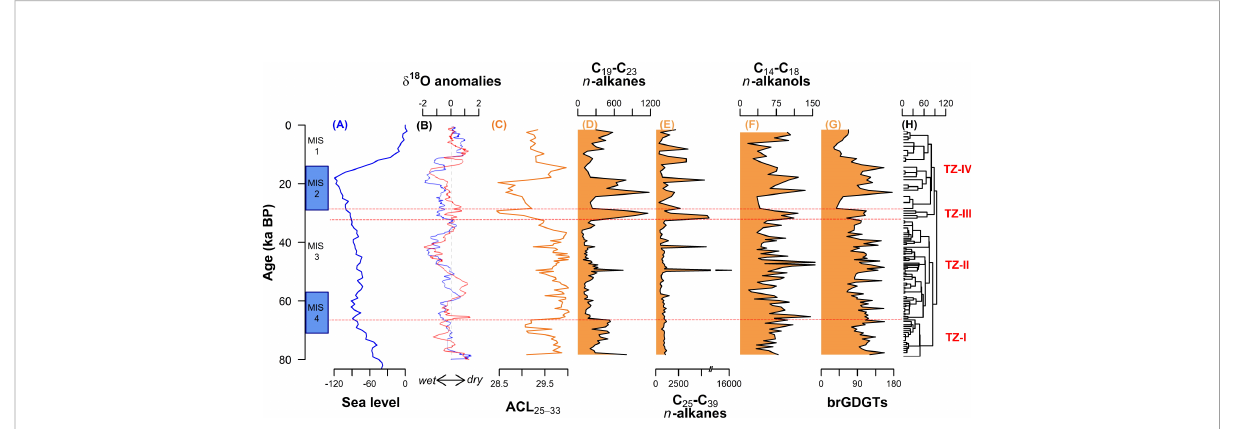
FIGURE 5 (A) Global sea level evolution (in m) (Miller et al., 2005). (B) Anomalies of d 18 O from the Botuvera ́ (red) and Santana (blue) caves (Cruz et al., 2005; Cruz et al., 2007). (C) n-alkane ACL 25-33 index from NAP 63-1 core. (D-G) Summary diagram showing the mass accumulation rates (in ng cm − 2 year − 1 ) of the organic molecular markers associated with terrestrial organic matter, (H) the constrained dendrogram, and the terrestrial zones (TZ) for core NAP